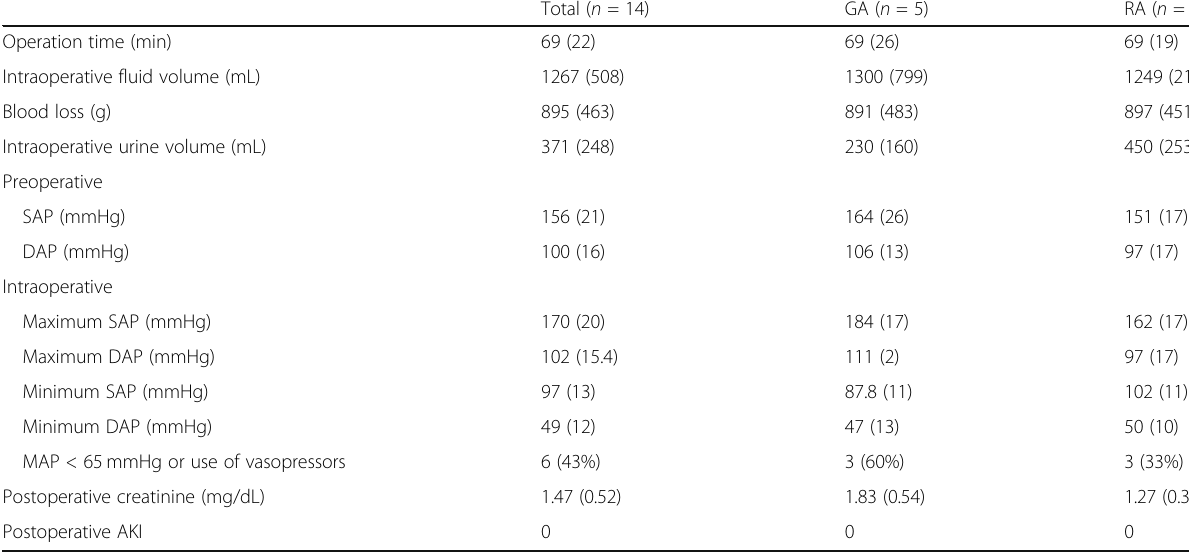
Table 2 Surgical information